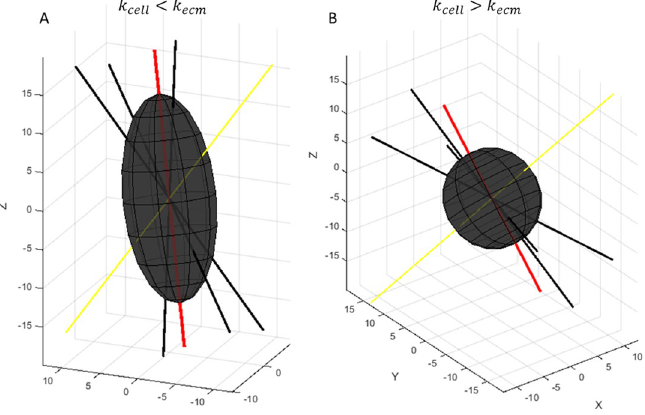
Fig 11. Cell sphericity. A) deformation of soft cell in stiff matrix B ) deformation of a stiff cell in a soft matrix. The yellow line represents the cells previous fiber, the black lines are the surrounding fibers, and the red line is the elongation vector, v e